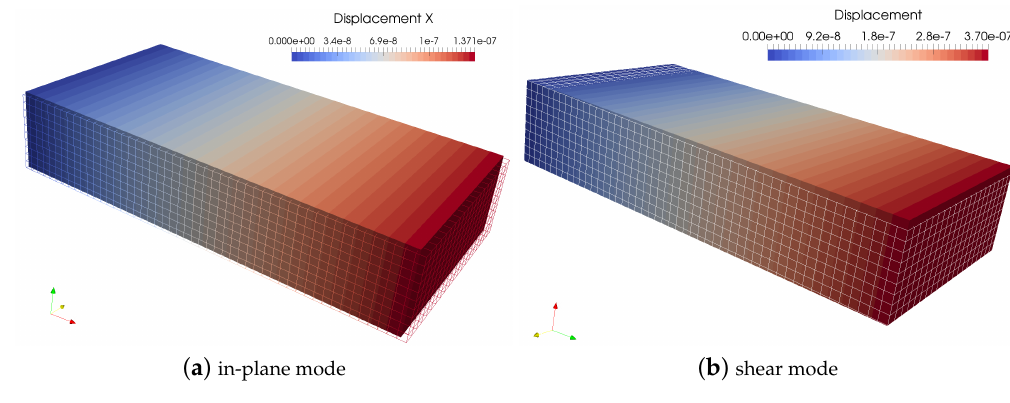
Figure 3. Single-layer beam under tensile and shear displacement. Table 3. Displacement prediction from the FEM solver with different types of elements (tetrahedral and hexahedral) for a single-layer PZT beam under tensile and shear load.